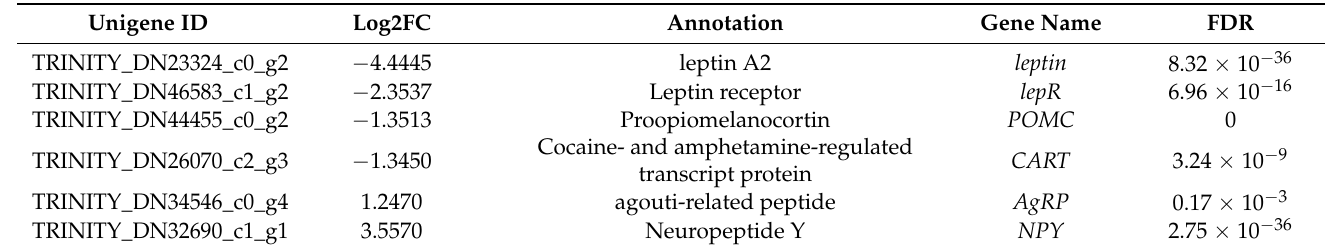
Table 2. Some candidate DEGs associated with appetite identified by pairwise-comparisons of diploid and tetraploid